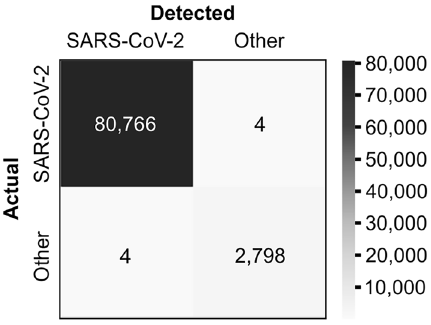
Figure 1. Specificity of primer pairs used in screening test. Bioinformatic confusion matrix of chosen primer pair sequences vs. SARS-CoV-2 genomes and other Coronaviridae